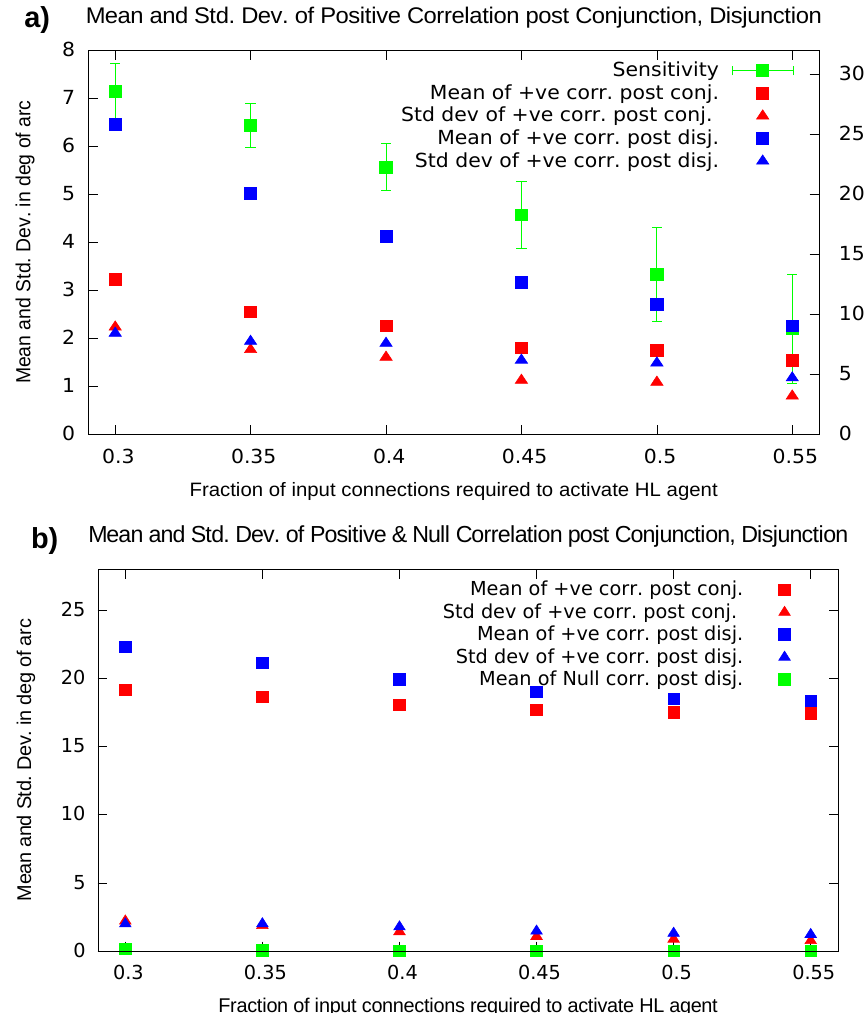
Figure 11. The results presented here include the means and standard deviations of variation in the range of positive and null correlation that resulted from conjunction and disjunction operations for different activation limits. To spare the clutter in the graphs, the standard deviation for a given mean (filled square) is shown as a separate point (filled triangle) in the same color, except for the sensitivity data in ( a ), for which the scale on the right hand y -axis applies. For ( a ), the entire orientation space was divided between positive and negative correlations, whereas for ( b ), a constant null range of correlation was included for LL agents. For activation limits >0.5, several of HL agents did not turn active for any orientation